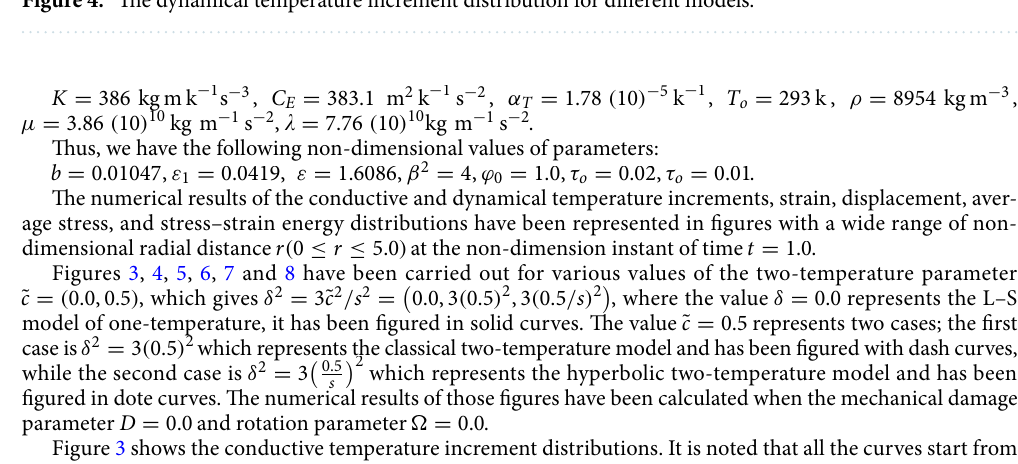
Figure 4. The dynamical temperature increment distribution for different